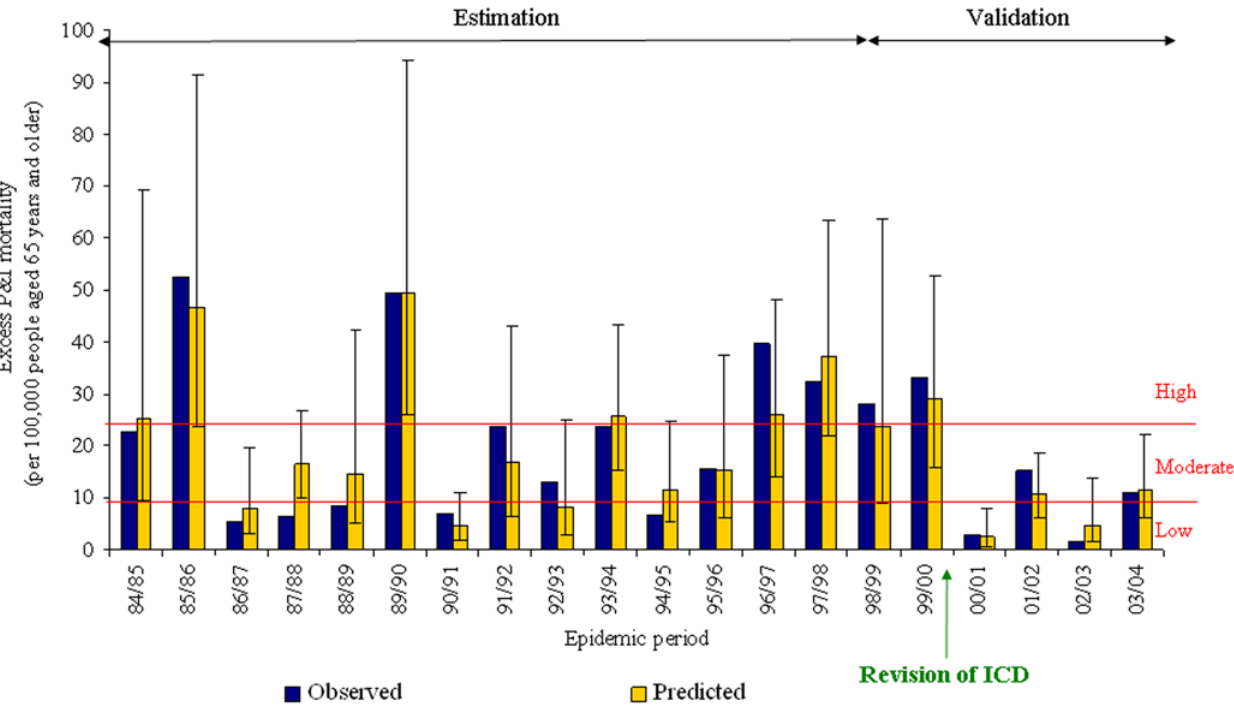
Figure 2. Observed and predicted excess P&I mortality cumulated by epidemic periods in persons over 65 years. Predicted values are presented with their 95% confidence intervals. The red lines represent the tertiles of the observed P&I mortality. P&I: pneumonia and influenza. ICD: International Classification of Diseases.